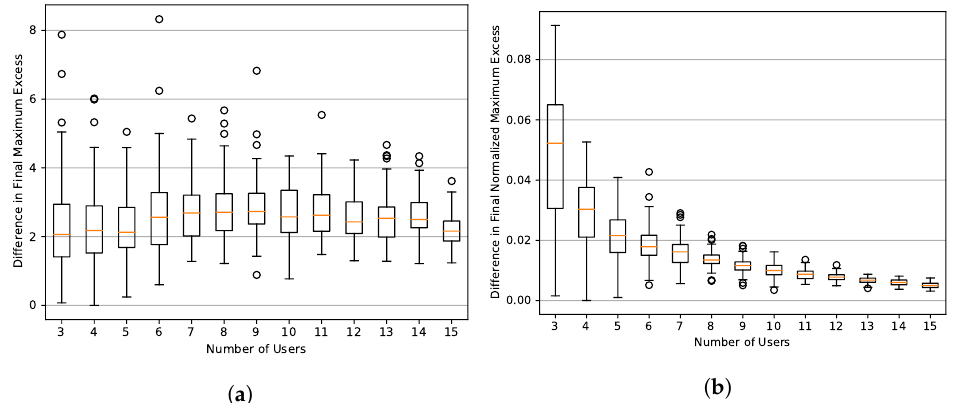
Figure 7. Boxplot of difference between final maximum excess ( a ) and normalized maximum ex- cess ( b ) of day-wise and full-period nucleolus in 1000 trials separated by the number of users in the community.